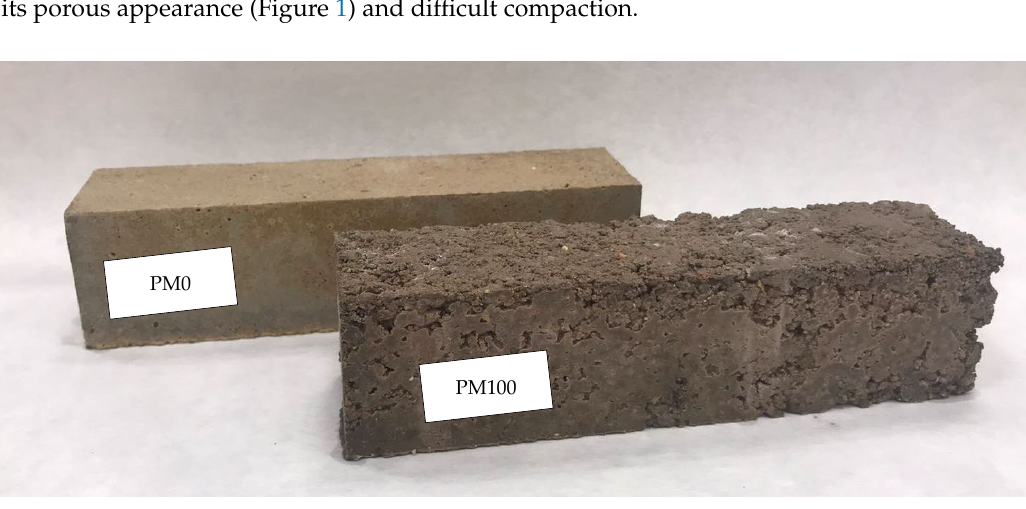
Figure 2. Mechanical strength comparison: ( a ) compressive strength; ( b ) flexural strength.